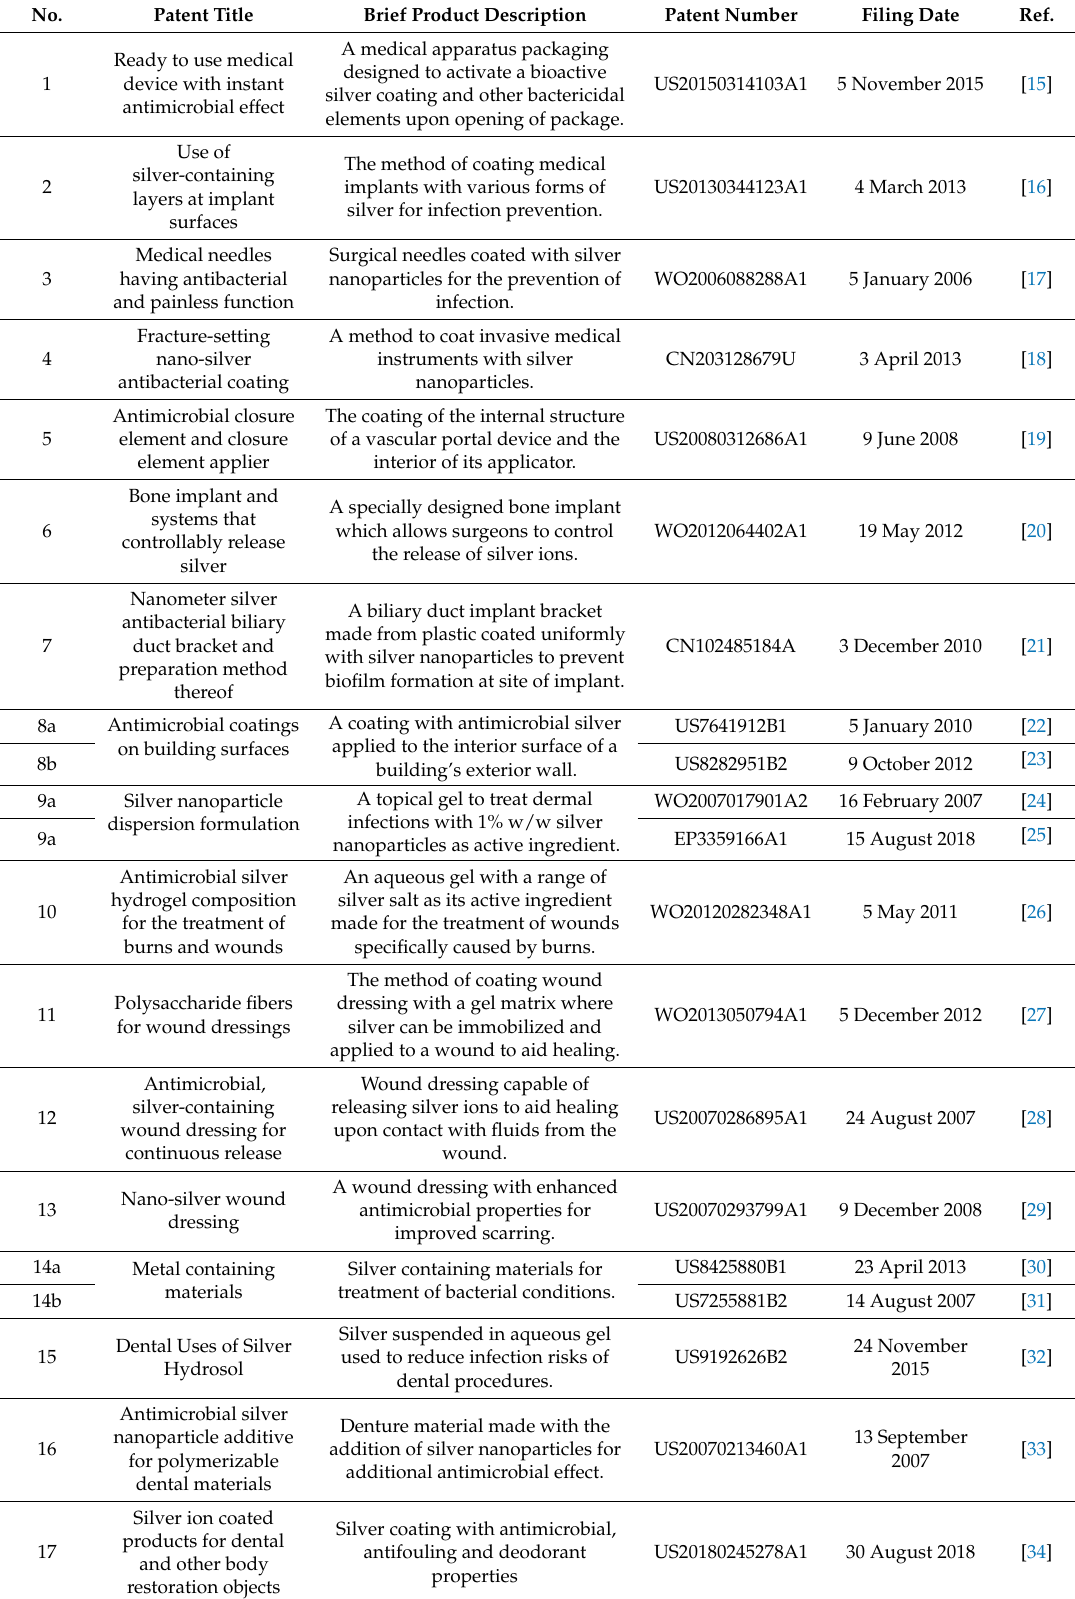
Table 1. List of patented medical grade products and medically related products containing silver as an antimicrobial